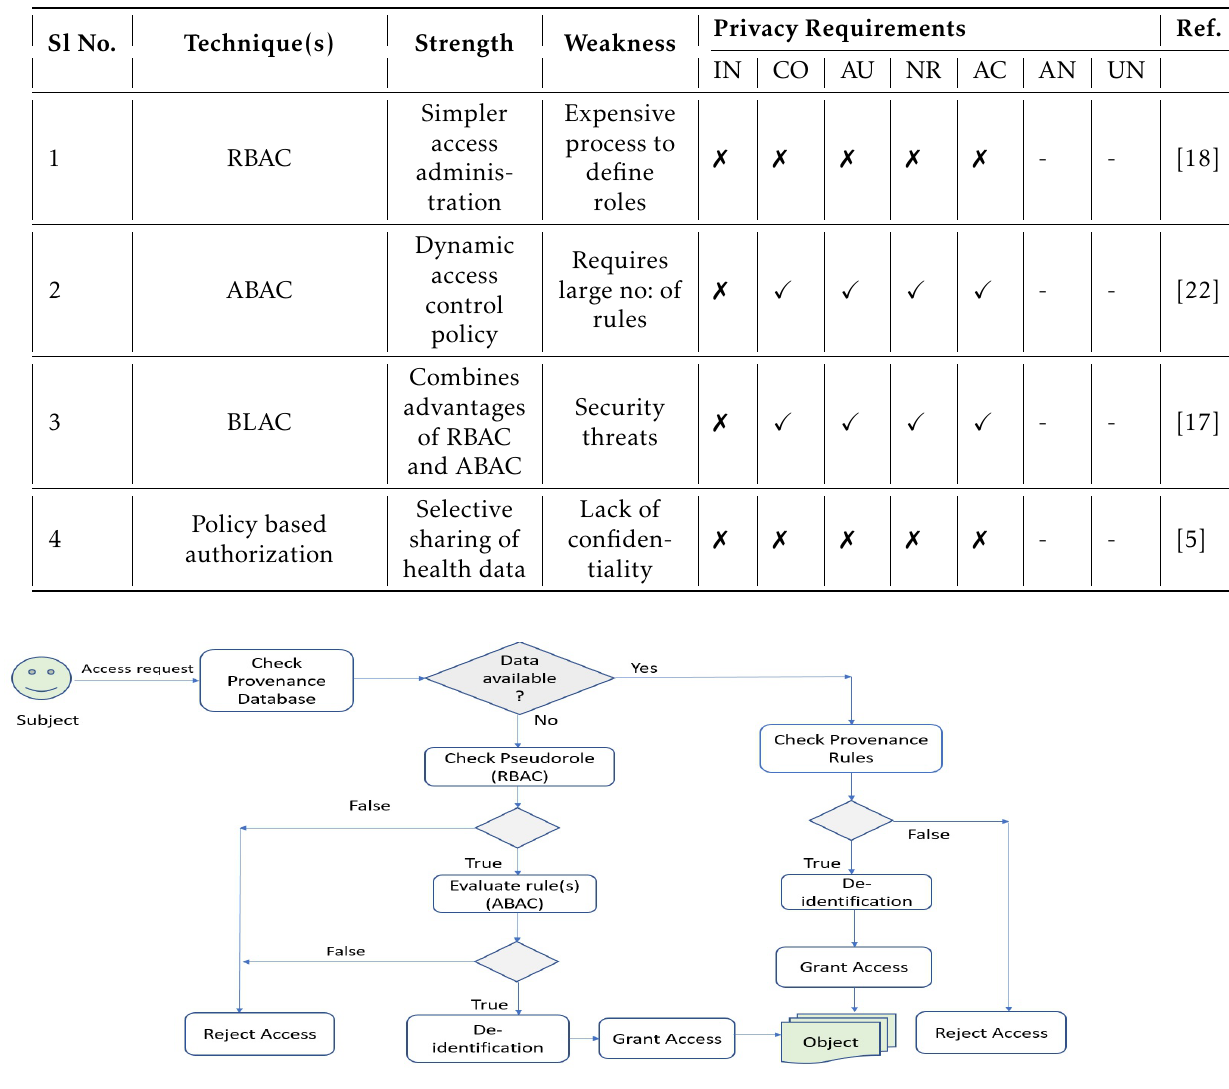
Table 2. Comparison of Privacy Preserving Non-Cryptographic Mechanisms Sl No.